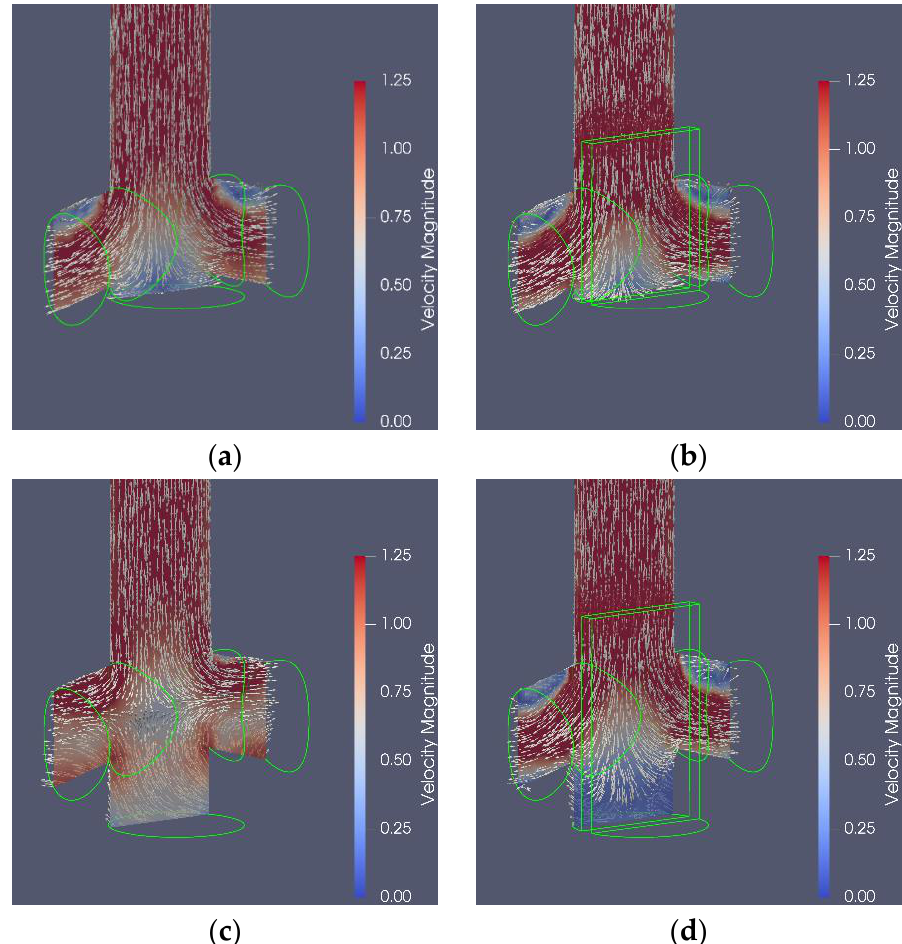
Figure 8. Fluid velocity maps on a slice. ( a ) FB-nozzle. ( b ) FBFD-nozzle. ( c ) WB-nozzle with 10 mm